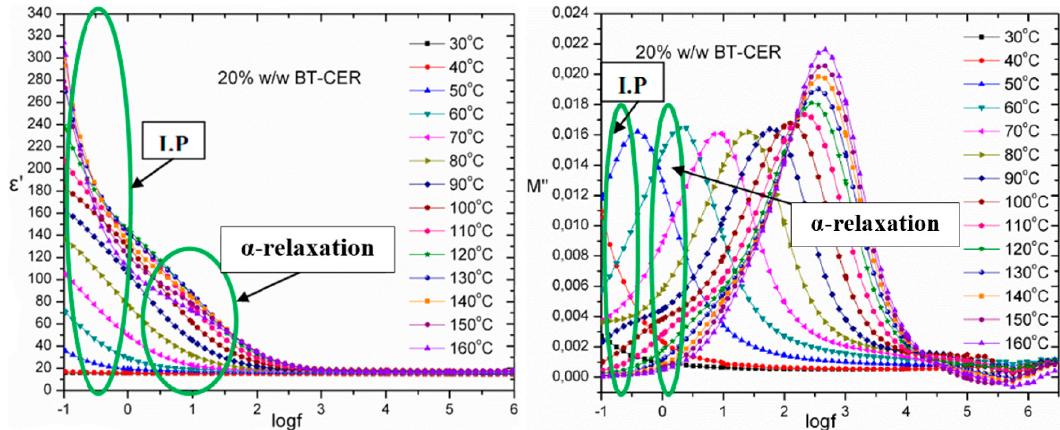
Figure 11. The real part of the dielectric permittivity ( left ) and the imaginary part of the electric modulus ( right ), versus frequency, for the 20% w/w BaTiO 3 -CER nano-composites.